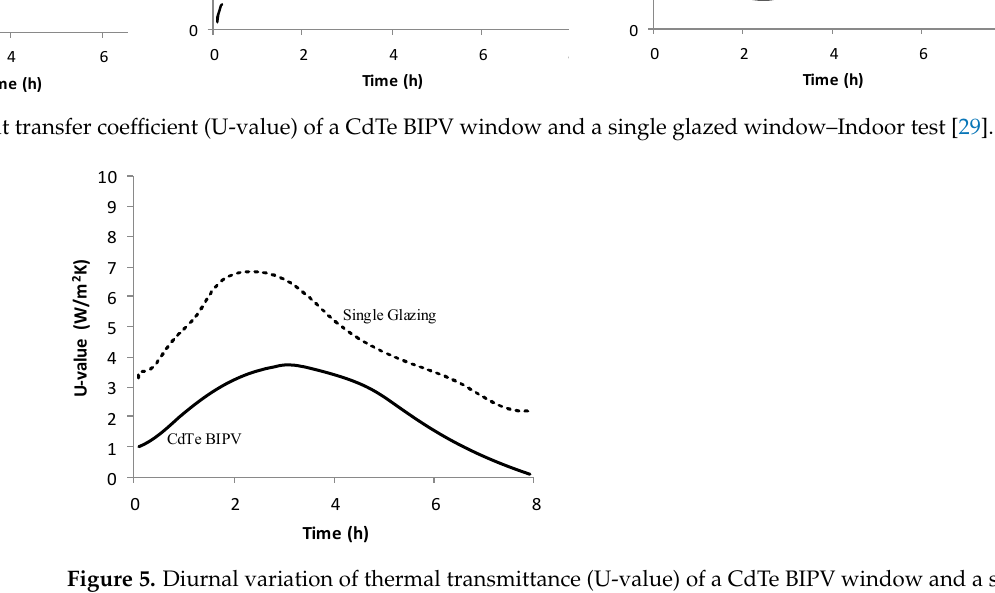
Figure 5. Diurnal variation of thermal transmittance (U-value) of a CdTe BIPV window and a single